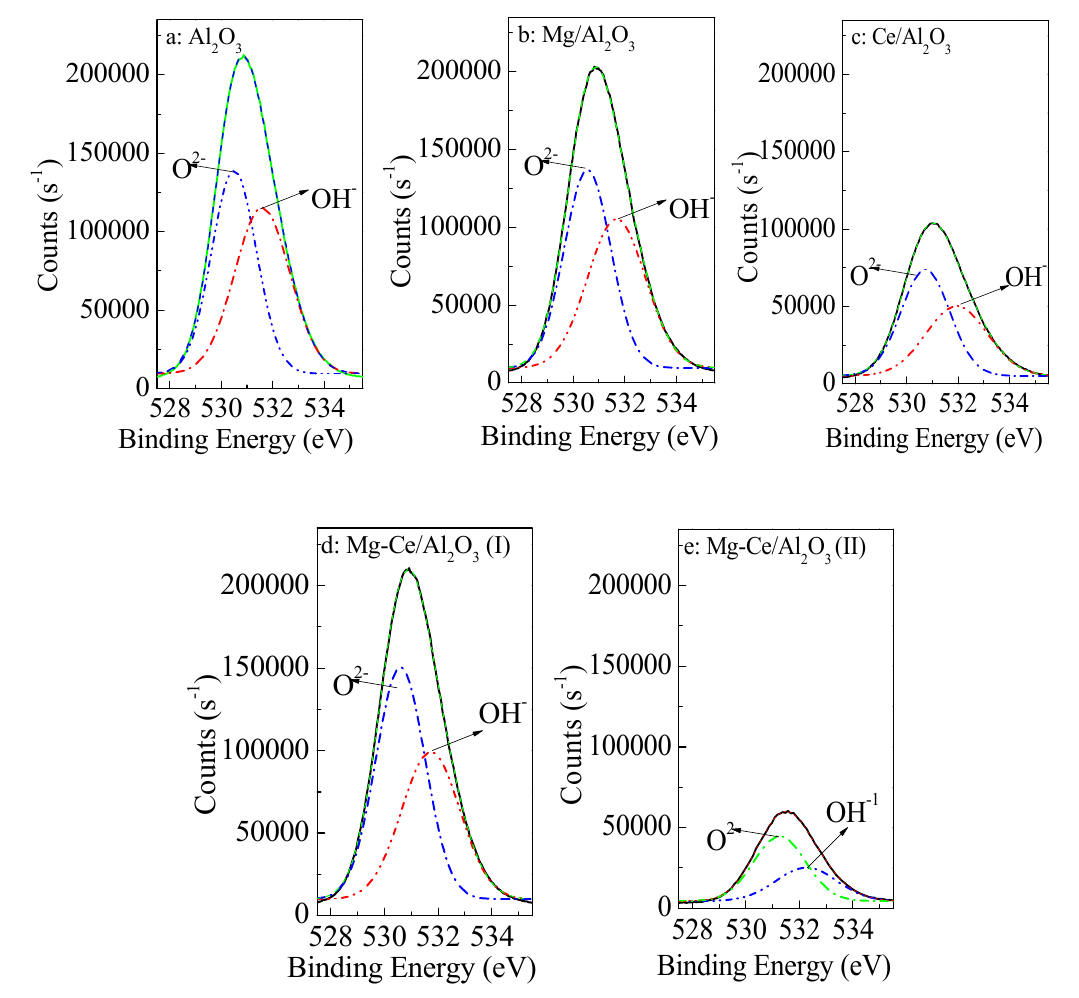
Figure 10. XPS spectra of O1s of Al 2 O 3 and metal oxide ‐ loaded Al 2 O 3 catalysts. ( a ) Al 2 O 3; ( b ) Mg/Al 2 O 3 ; ( c ) Ce/Al 2 O 3 ; ( d ) Mg ‐ Ce/Al 2 O 3 (I); ( e ) Mg ‐ Ce/Al 2 O 3 (II).